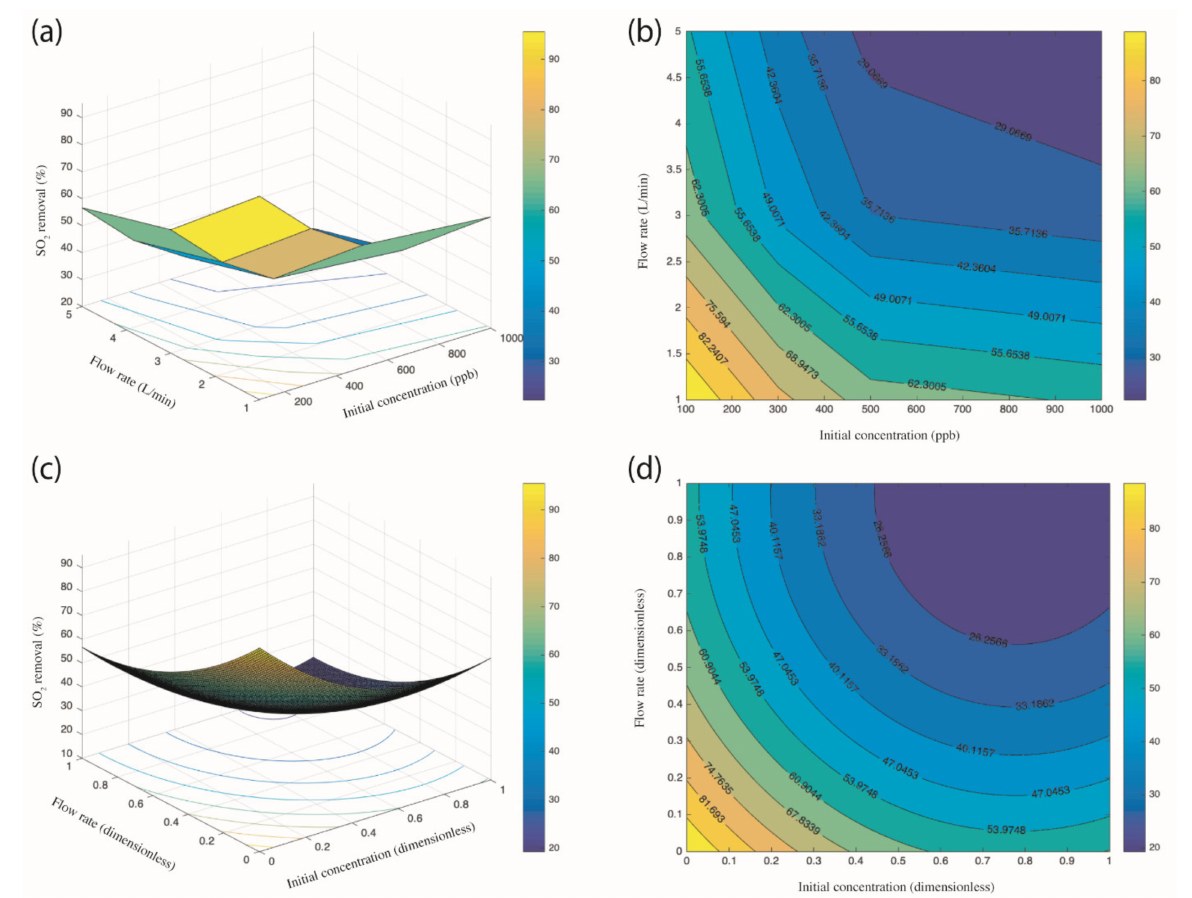
Figure 12. Respond surface and colored contour map: ( a ) respond surface (original data); ( b ) contour map (original data); ( c ) respond surface (normalized data); ( d ) contour map (normalized